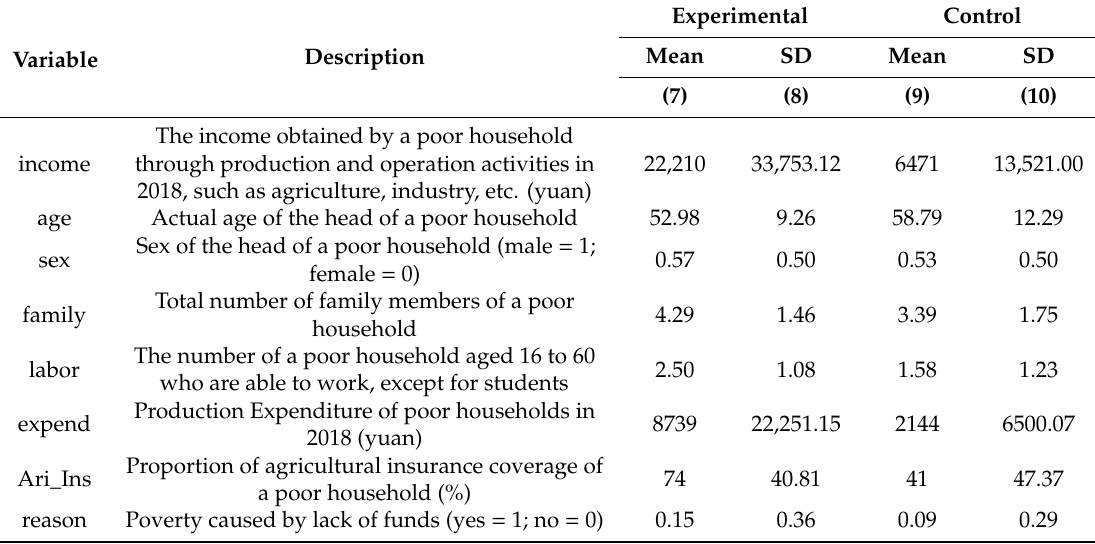
Table 2. Descriptive statistical results of the